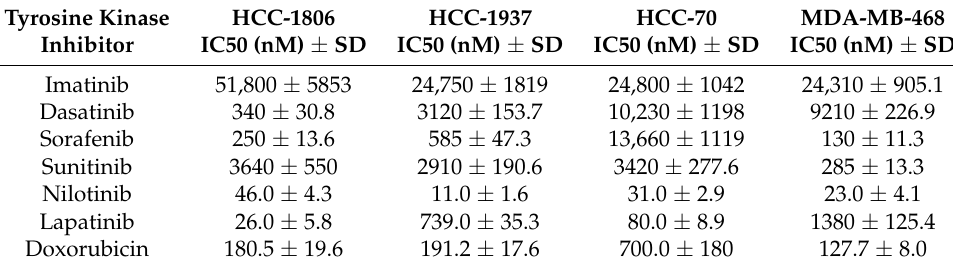
Figure S2. Lapatinib was included as a control because it does not target c-Kit (Figure S2). Doxorubicin was included in order to compare cytotoxicity that was induced by TKIs with that which was produced by traditional chemotherapy. The cytotoxic effect was expressed as the IC50 of each TKI. The results that are shown in Table 1 indicate that the TNBC cells were susceptible to all TKIs that were tested. However, distinct levels of response were detected. Imatinib had the weakest cytotoxic effect with calculated IC50 values >20,000 nM in all cell lines (51,800 nM in HCC-1806, 24,750 nM in HCC-1937, 24,800 nM in HCC-70, and 24,310 nM in MDA-MB-468). The response to Dasatinib was highly heterogenous; HCC-1806 were the most susceptible cells with an IC50 of 340 nM, followed by HCC-1937 (3120 nM), MDA-MB-468 (9210 nM), and HCC-70 (10,230 nM). The cytotoxic effect of Sorafenib also varied among cell lines. In this case, MDA-MB-468 were the most susceptible cells, with a calculated IC50 of 130 nM. The less susceptible cells were HCC-70 with an IC50 of 13,660 nM. The cytotoxic profile of Sunitinib was relatively high in the MDA-MB-468 cells (IC50 = 285 nM), compared with that which was observed in HCC-1806 (3640 nM), HCC-1937 (2910 nM), and HCC-70 (3420 nM). In sharp contrast, Nilotinib had the highest cytotoxic profile in all the cell lines, also showing the most homogenous response among the cell lines with IC50s < 50 nM (46 nM in HCC-1806, 11 nM in HCC-1937, 31 nM in HCC-70, and 23 nM in MDA-MB-468). Table 1. Calculated IC50 values for Tyrosine Kinase